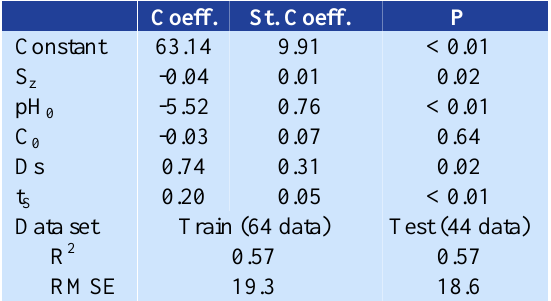
Figure 2. Sample plot of the artificial neural networks (ANN) (left) and multiple linear regression (MLR) (right) predicted values of dye removal (DR%) (colored surface) versus experimental data of DR% (black dot), for three sample conditions Table 2. The MLR model and related statistical characteristics